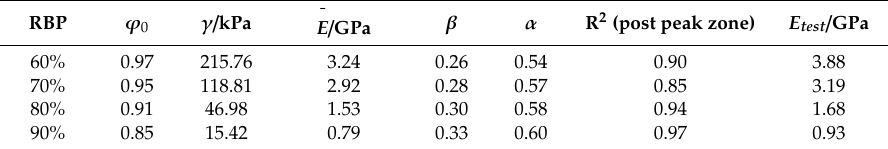
Figure 10. Fitting results. Table 2. Calibration results of constitutive parameters.